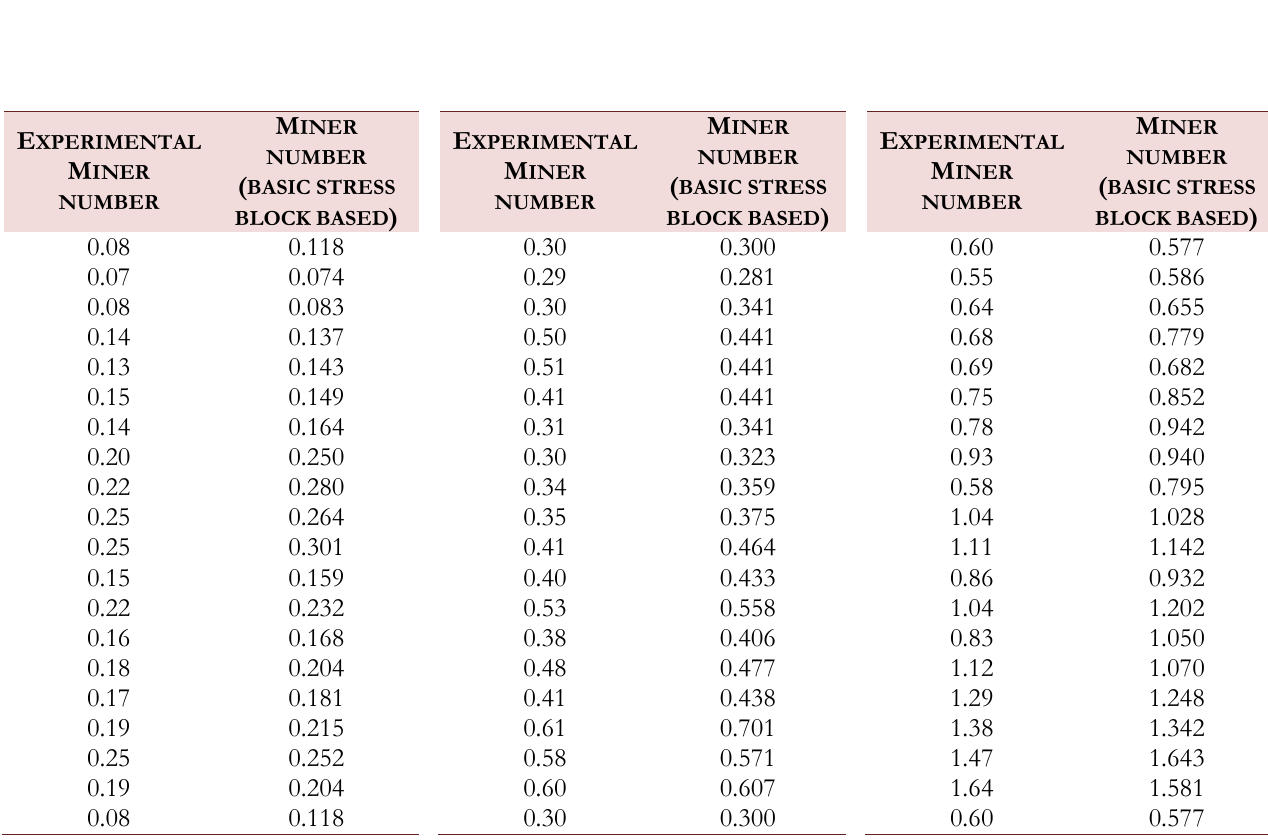
Table 4: Comparison between the Miner numbers estimated using the basic stress block approach proposed in this work and those directly overtaken from Holmen (shown in increasing